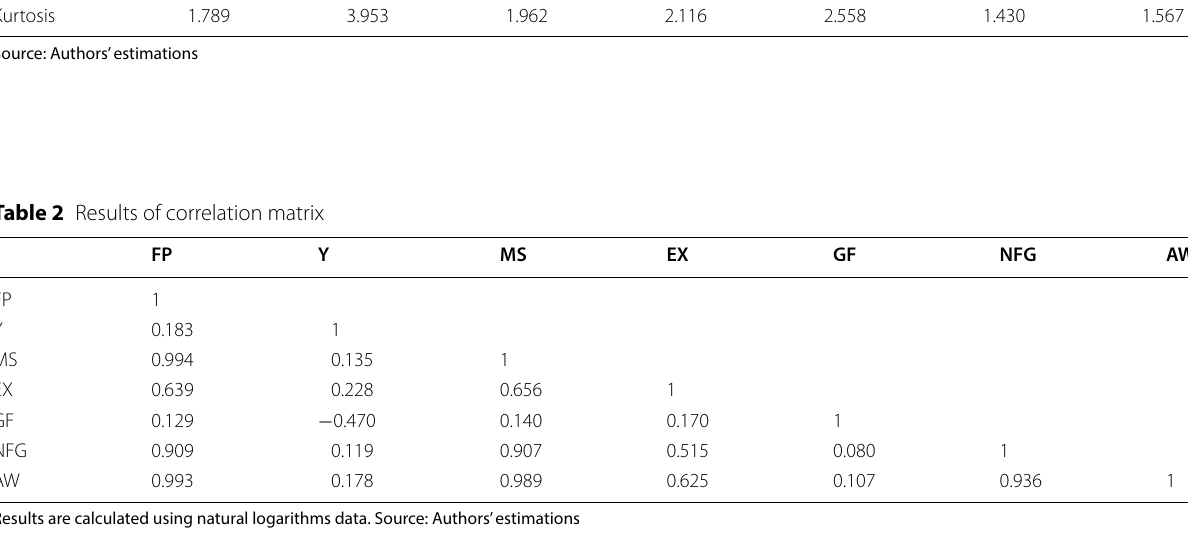
Results are calculated using natural logarithms data. Source: Authors’